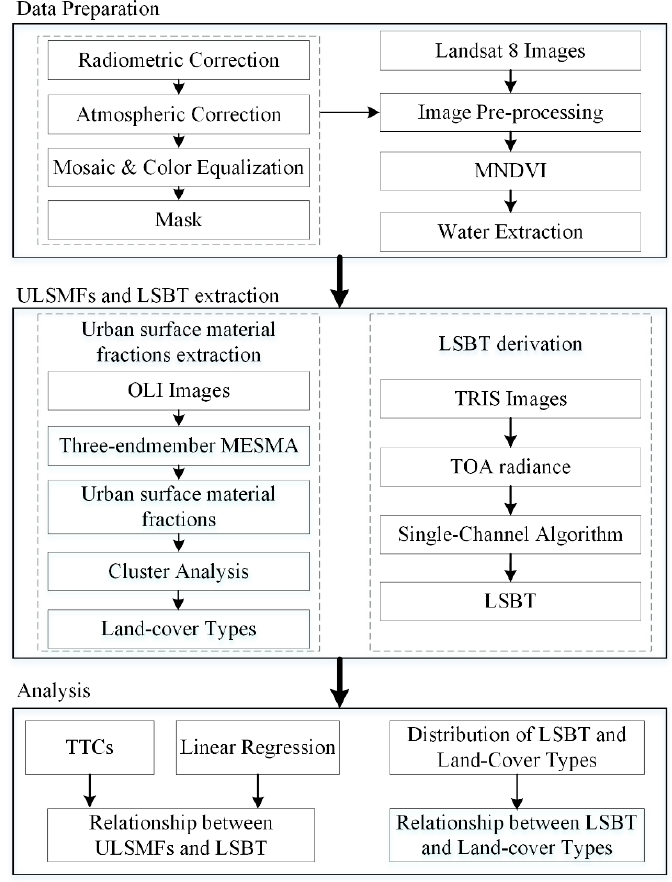
Figure 2. Flow chart of the proposed methods in this study.